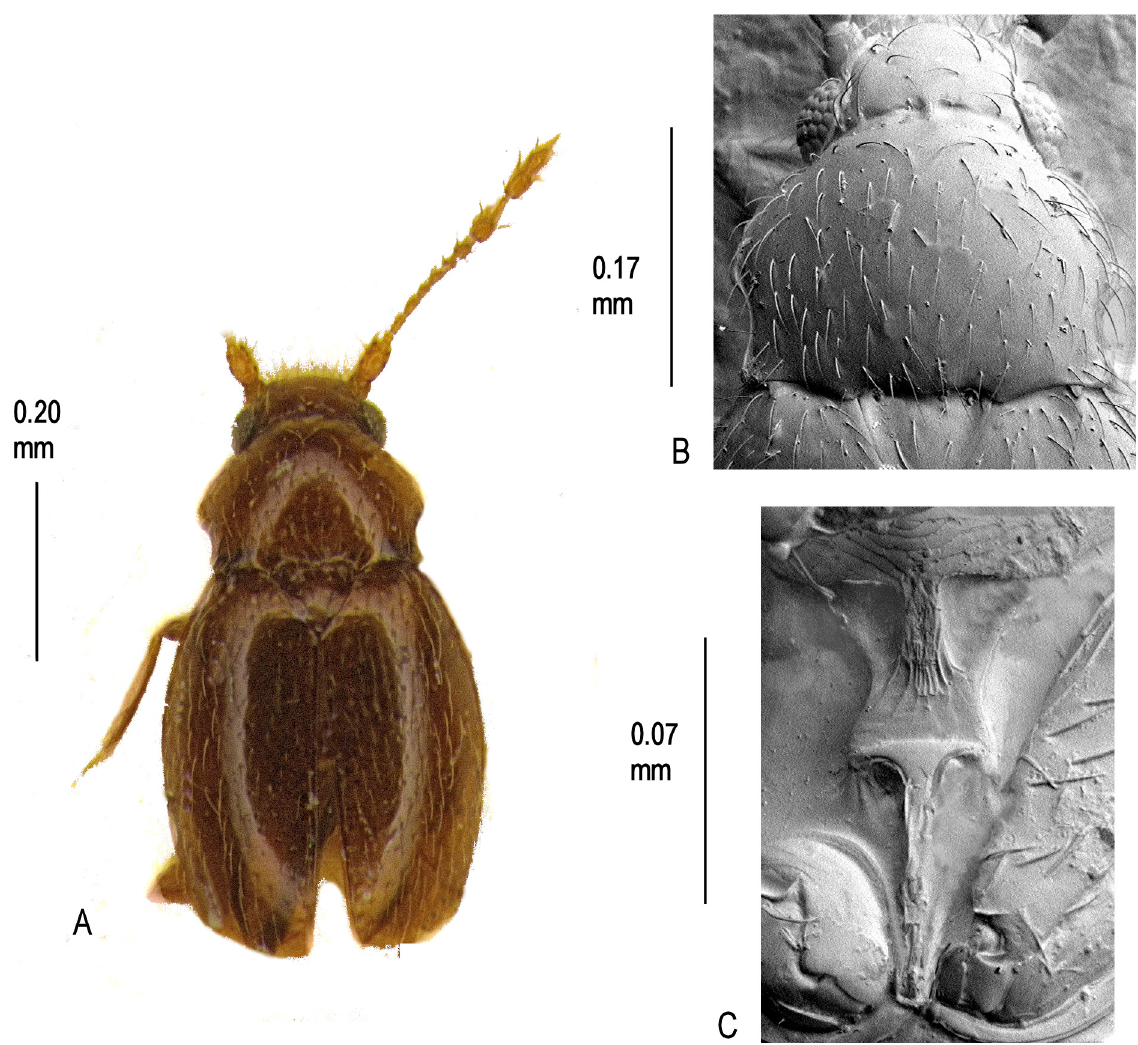
Fig. 105 . Cissidium subangulatum sp. nov. A . Habitus. B . Pronotum, × 585. C . Mesoventrite showing median process of collar, mid-keel and keel,